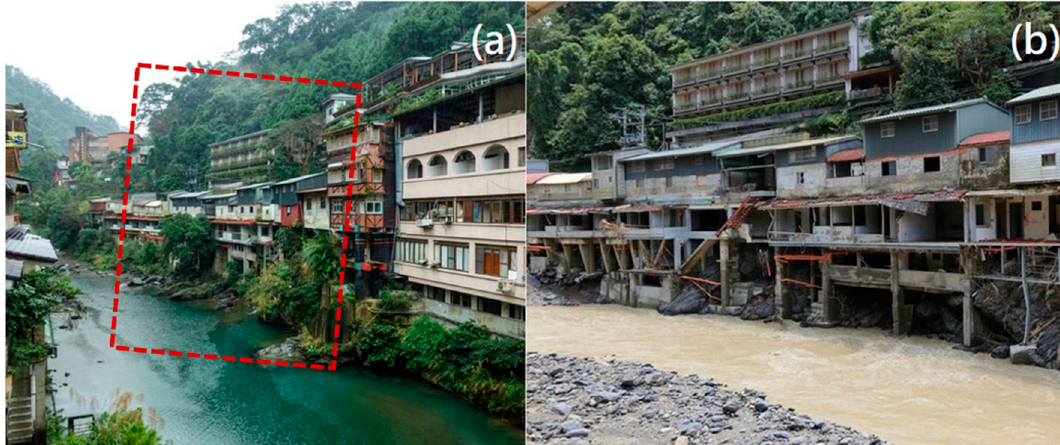
Figure 3. The exteriors of buildings along the Tonghou River ( a ) before and ( b ) after the mountain flash flood induced by Typhoon Soudelor (2015) (Photo source: [16]).